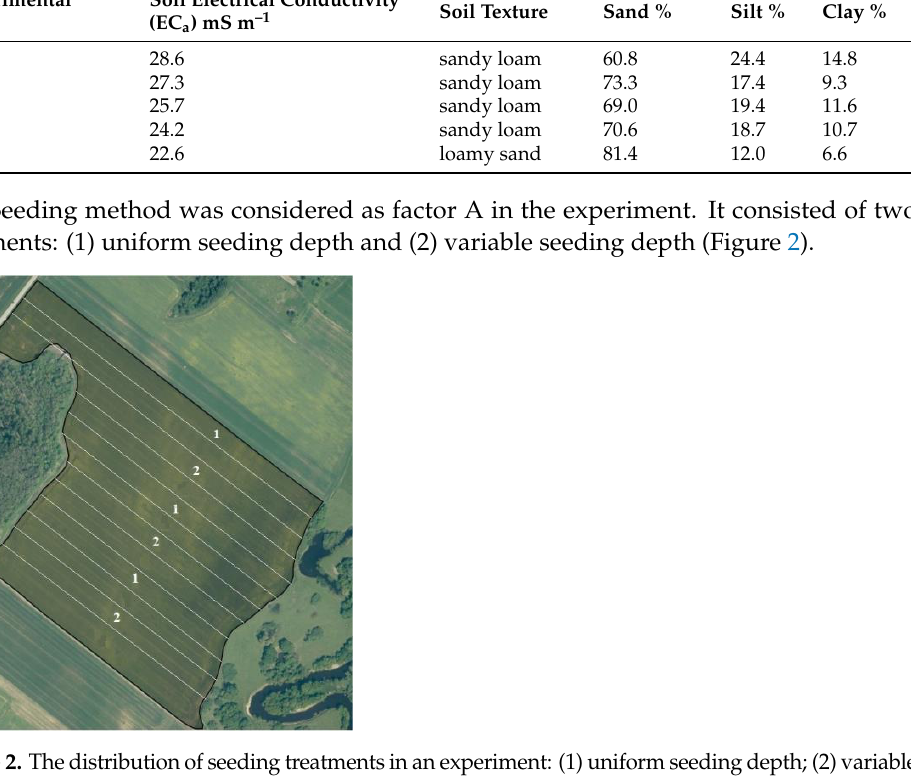
Table 1. Soil electrical conductivity, texture and granulometric composition. Experimental Zone